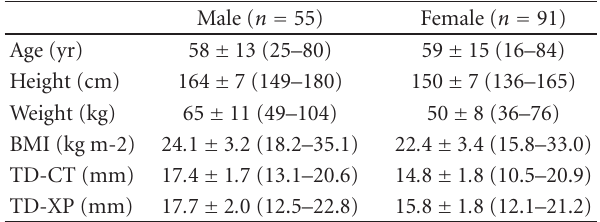
Table 1: Patient